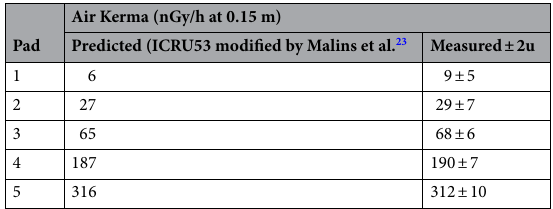
Table 2. Radiation fields above the pads (KERMA) as predicted using ICRU data modified by Malins et al. 23 , and as measured following the RSS-131ER HPIC protocol.